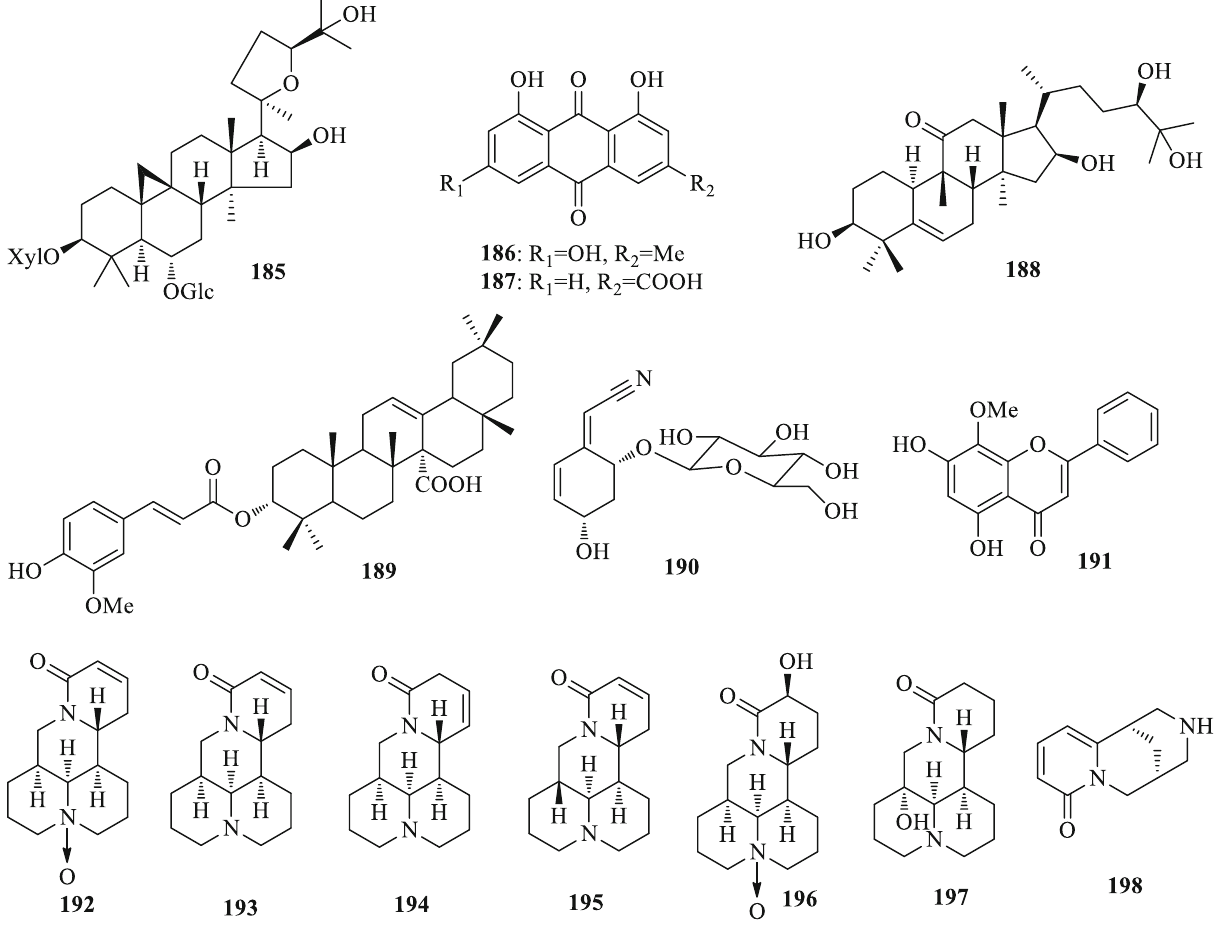
Fig. 13 Structures of compounds 185 –